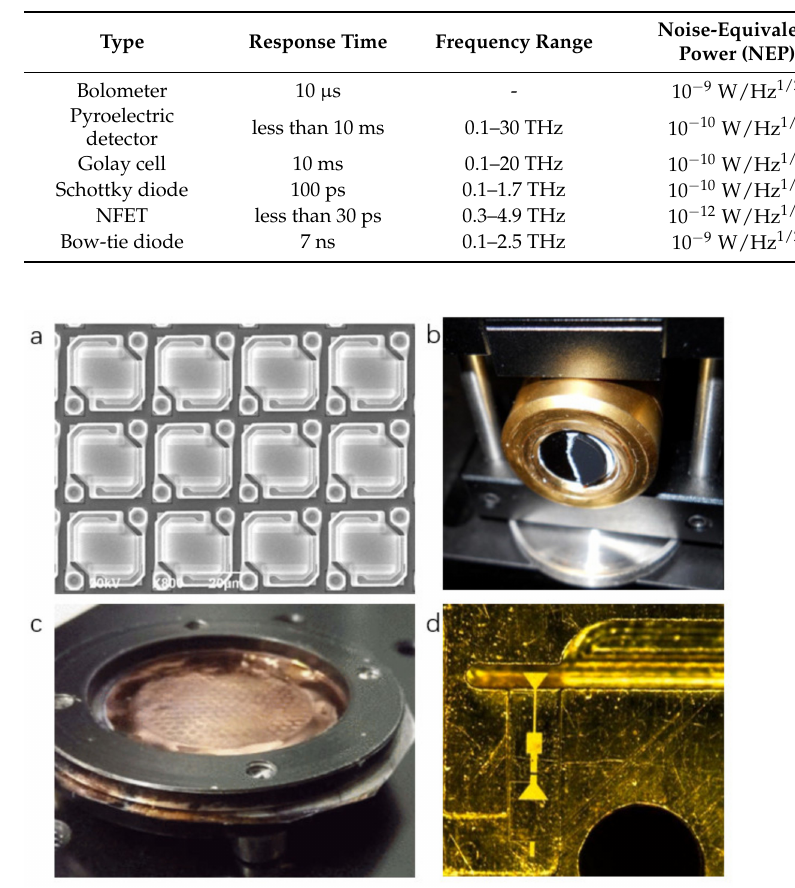
Table 1. Performance parameters of terahertz detectors.